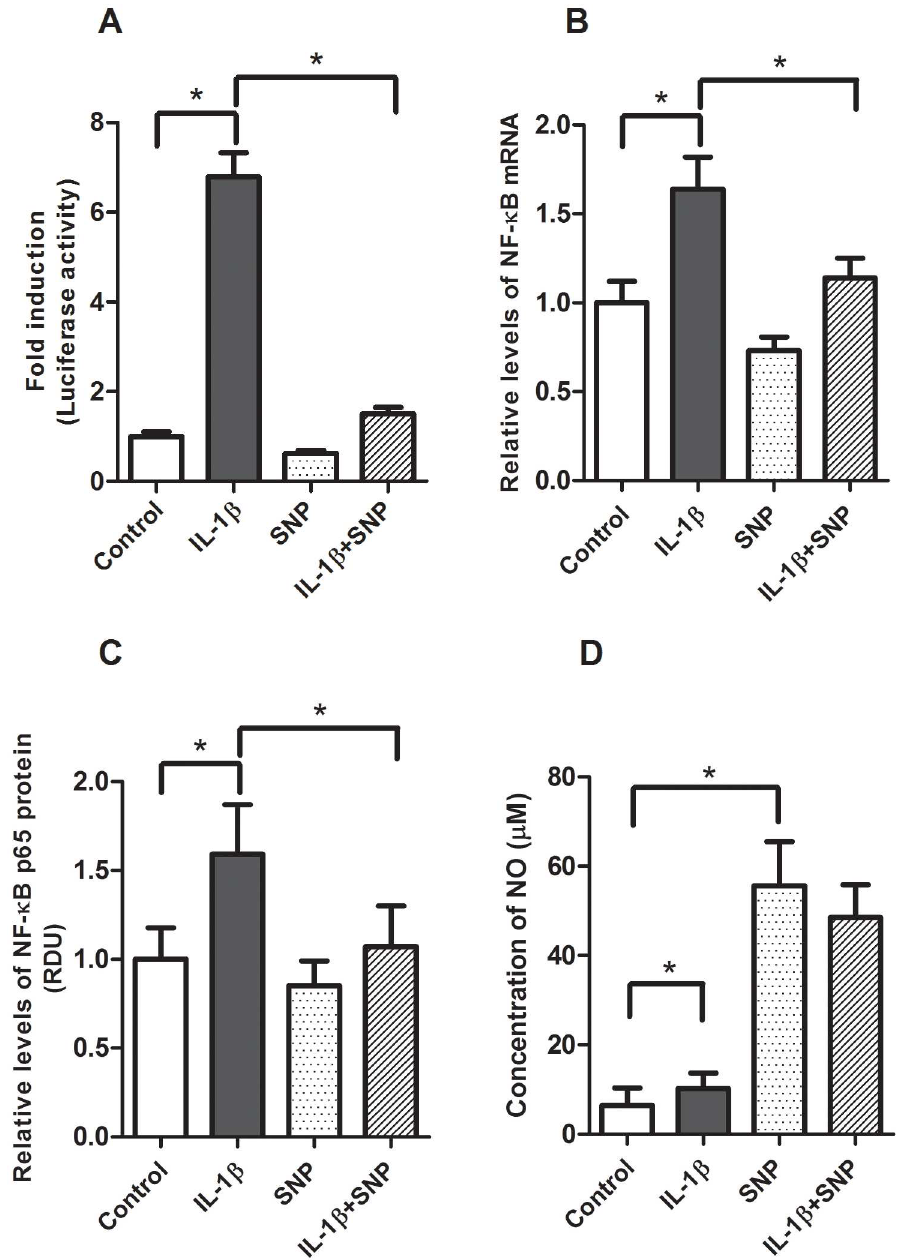
Fig 5. Effects of SNP in IL-1 β inducible NF- κ B promoter activity, expressionand NO production. Caco- 2 cells were transfected with pNF- κ B-Luc vector were treated with IL-1 β (4 ng/ml) for 4 hours after pretreatment of SNP (1 mM) for 4 hours. Cells were harvestedfor luciferase activity and isolationsof protein and total RNA. A: NF- κ B luciferase activity, data are expressedas fold-inductionof normalized luciferase activity. B: NF- κ B mRNA levels were determined by qRT-PCR, then normalized to β -actin. C: NF- κ B p65 protein was measuredby Western blot analysisand normalizedto β -actin. D: NO levels in cell culture media were measuredas describedin Methods. Data are means ± SE, * P < 0.05.(n = 4–6 /group).